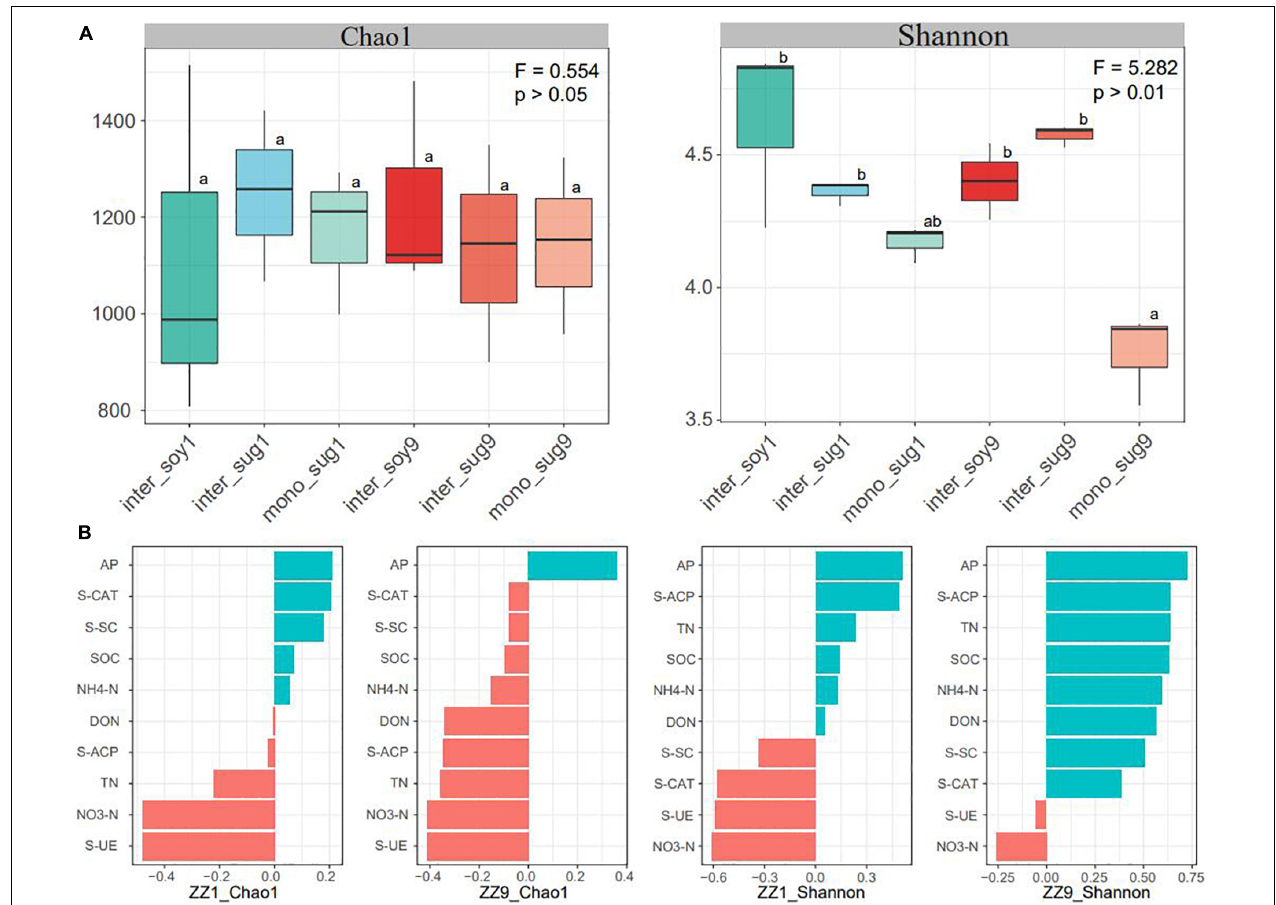
FIGURE 1 | (A) Bacterial alpha-diversity measurements of represented by Chao 1 and Shannon indexes in each pattern. F = Fisher’s F-ratio. p = p -value. Different letters next to the bars represent significant differences between the measured indices. (B) Pearson correlation analysis of alpha diversity and environmental factors showed positive correlation in blue and negative correlation in